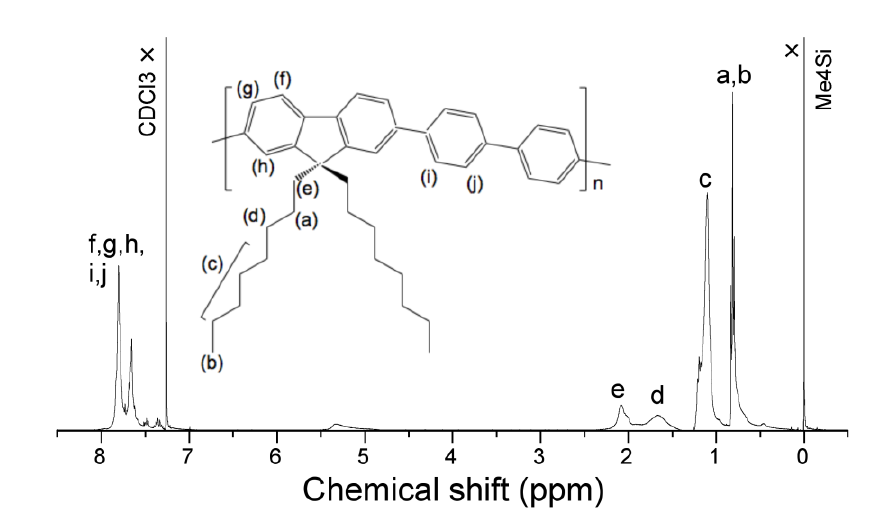
Figure 10. 1 H-NMR spectrum of PF8P2 in CDCl (399.00